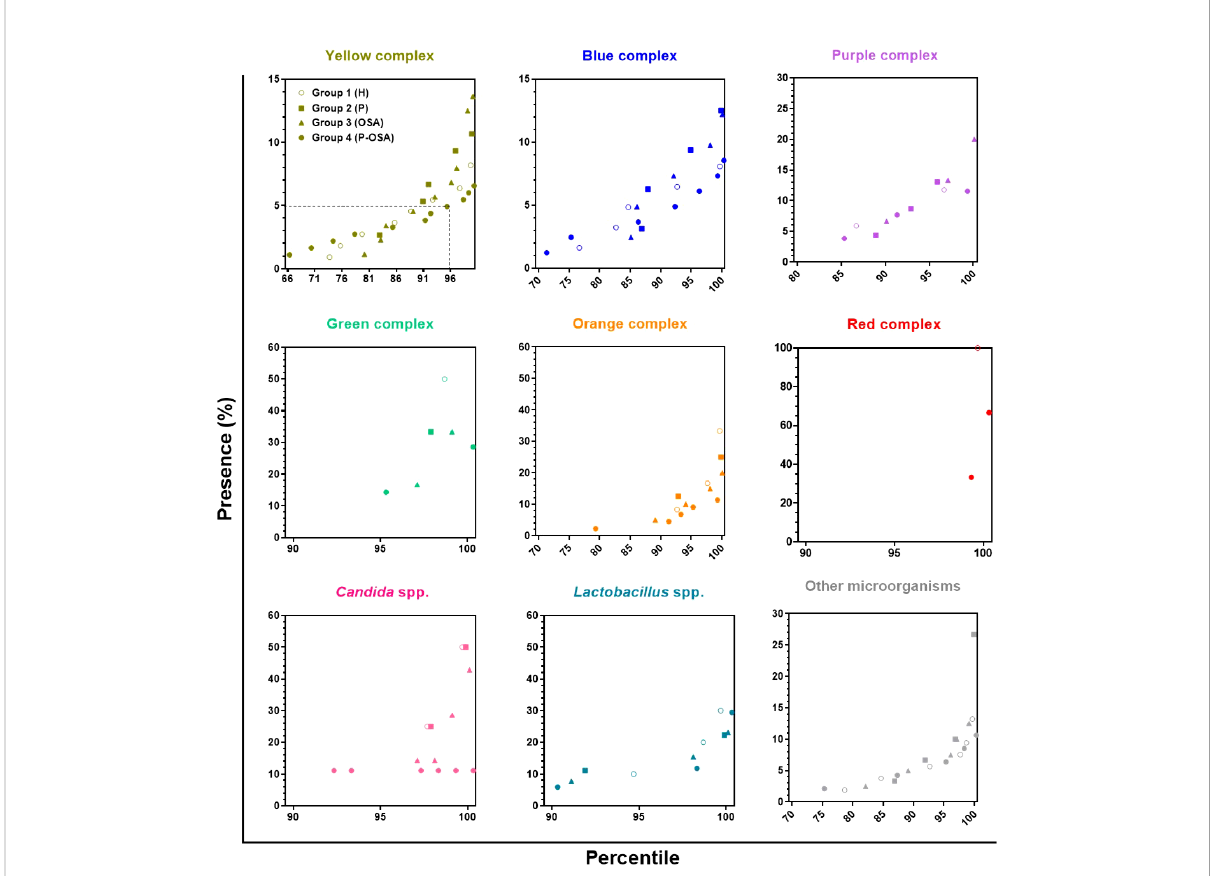
FIGURE 4 Percentile graph of the percentage of presence of complexes/categories in each of the groups of participants evaluated. Each point represents the presence (%) of the complex/category in a patient. The x-axis represents the percentiles, the y-axis the presence (%) of the complexes/ categories, and the dotted line in the fi rst panel indicates that 95% of the participants in Group 4 (P-OSA) have less than 5% presence of the yellow complex, on the other hand, 5% of the subjects of this same group exhibit > 5% presence of the yellow